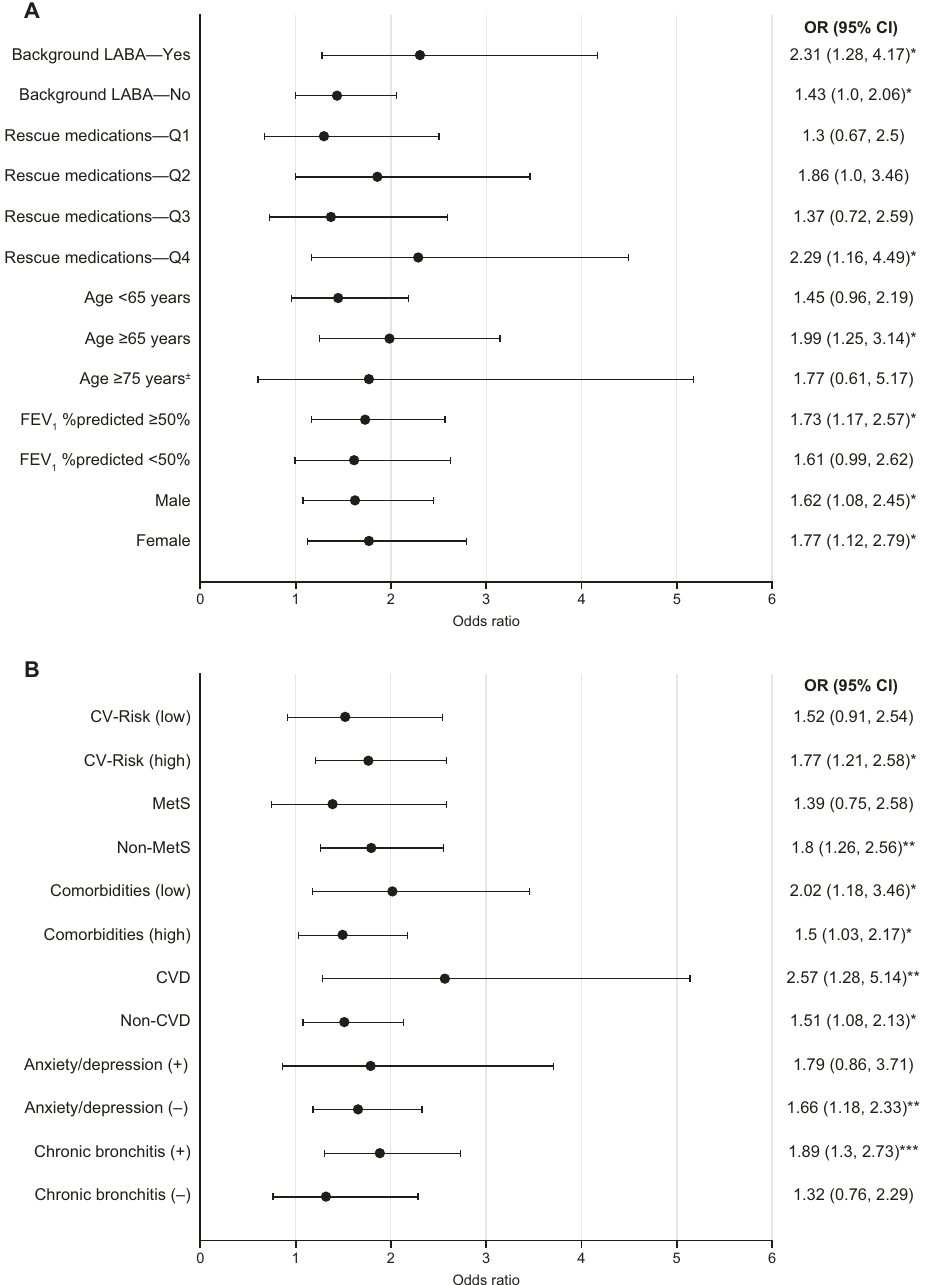
Fig. 4 SGRQ responder rates with GLY compared with placebo. Analysis by A baseline demographics and disease severity, and B comorbidities and chronic bronchitis at baseline. * p < 0.05; ** p < 0.01; *** p < 0.001 versus placebo, analyzed using a logistic regression model. CI con fi dence interval, CV cardiovascular, CVD cardiovascular disease, FEV 1 forced expiratory volume in 1 s, GLY nebulized glycopyrrolate, LABA long-acting β 2 -agonist, LS least squares, MetS metabolic syndrome, OR odds ratio, Q quartile, SGRQ St. George ’ s respiratory